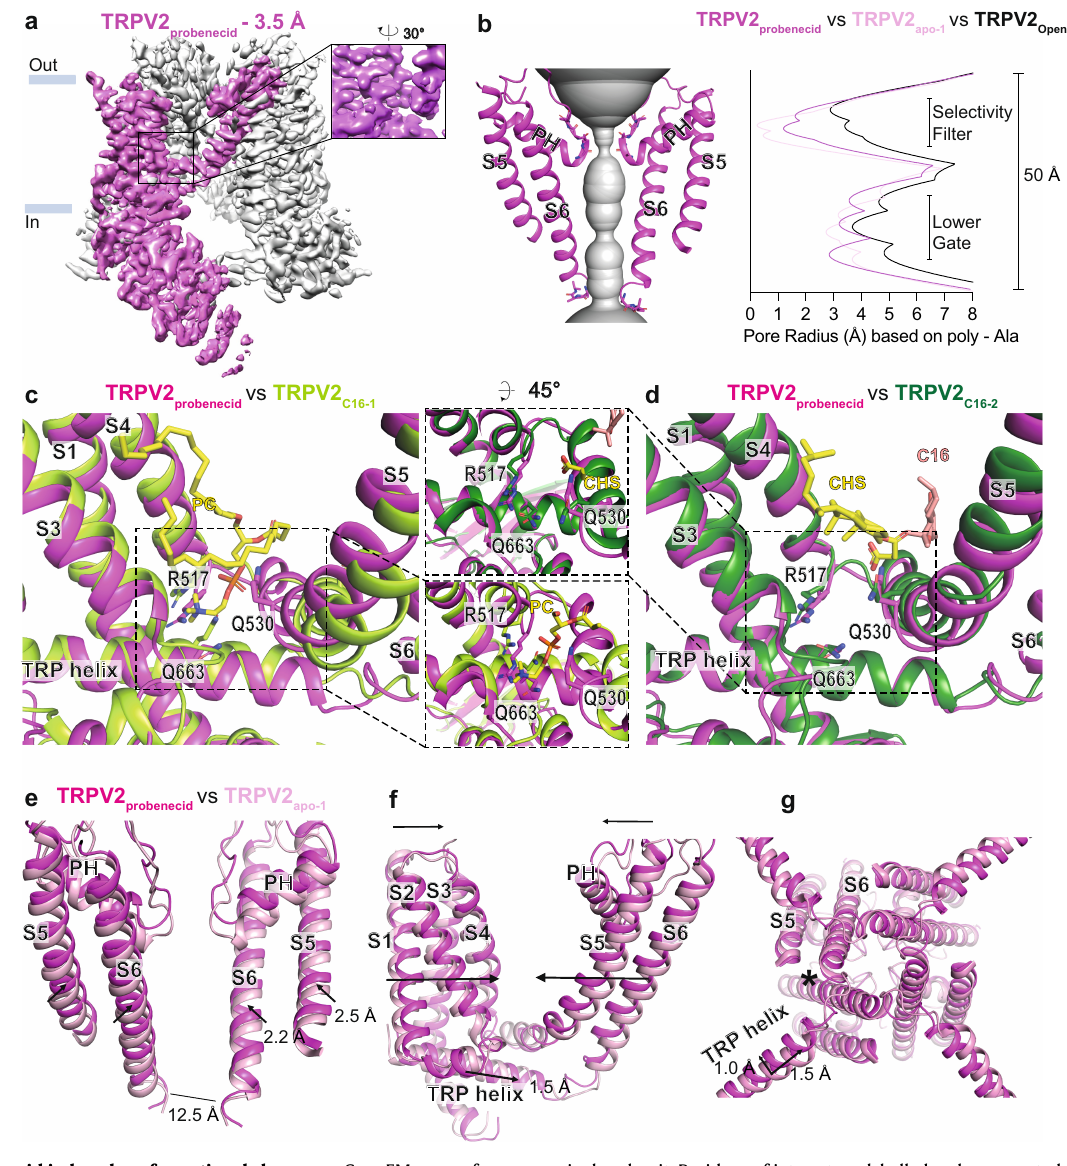
single subunit. Residues of interest are labelled and represented as sticks. Also shownarePC( c )and CHS( d )asyellowsticks,C16( d )aspinksticks. e - g Overlayof globallyalignedTRPV2 probenecid (magenta)andTRPV2 apo-1 (pink). e Membraneview comparisons of opposite pore-forming subunits. f Membrane view of the trans- membrane region of a single subunit illustrating the differences in the vanilloid pocket region. g Viewofthe pore from the intracellular sideofthe membrane. PH indicates pore helix, and arrows indicate structural movements of TRPV2 probenecid in relation to TRPV2 apo-1 . The length of the arrow displays the varying degrees of structural changes. Star indicates local conformational